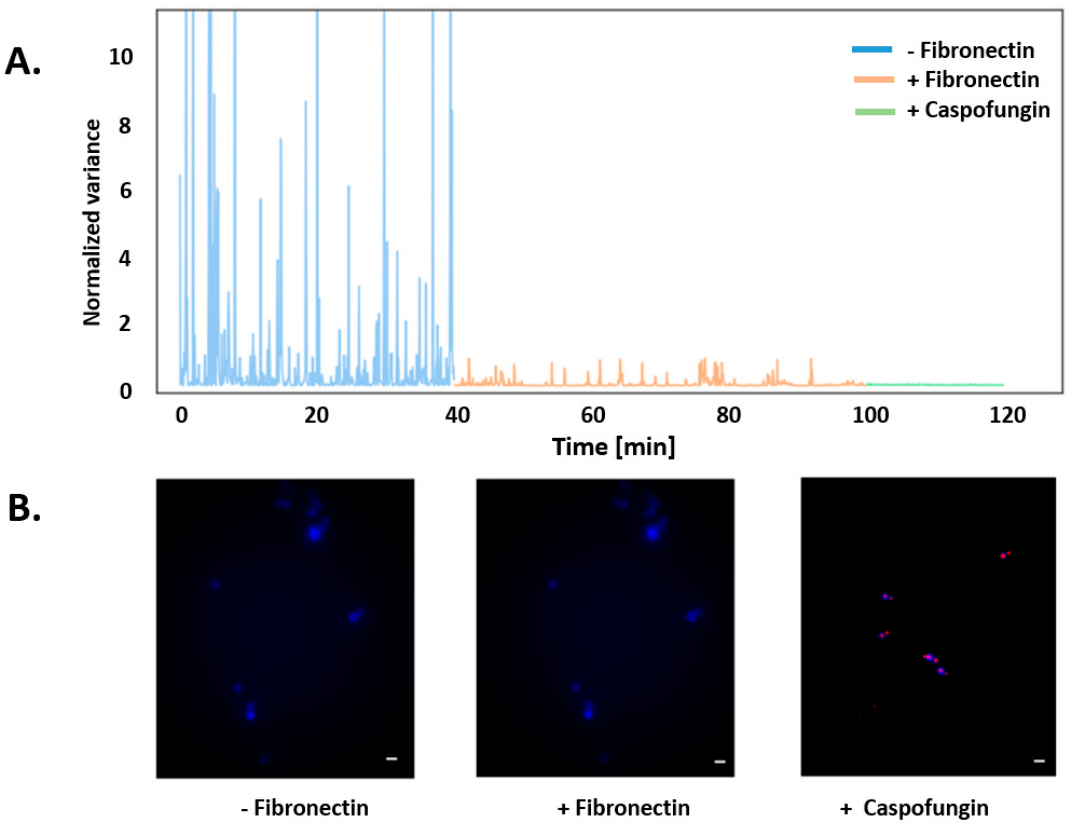
Figure 4. Viability assay of C. albicans . ( A ). Nanomotion signal of C. albicans isolate 101 in the absence (blue curve) and presence of fibronectin (orange curve), and after killing the cells by the antifungal caspofungin (green curve). ( B ). Representative fluorescence images of C. albicans isolate 101 in the absence (left panel) and presence of fibronectin (middle panel), and after killing (right panel). Scale bar 5 µm.